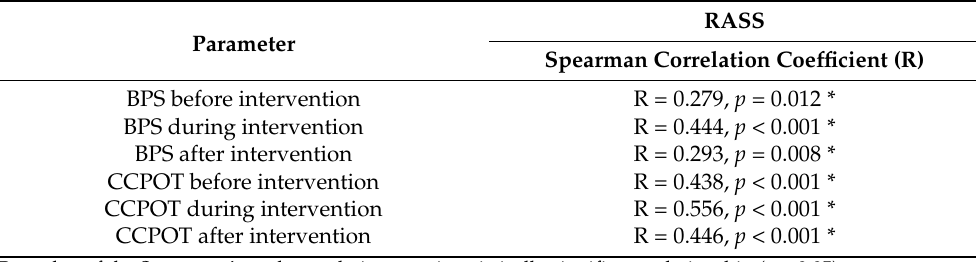
RASS Spearman Correlation Coefficient (R)